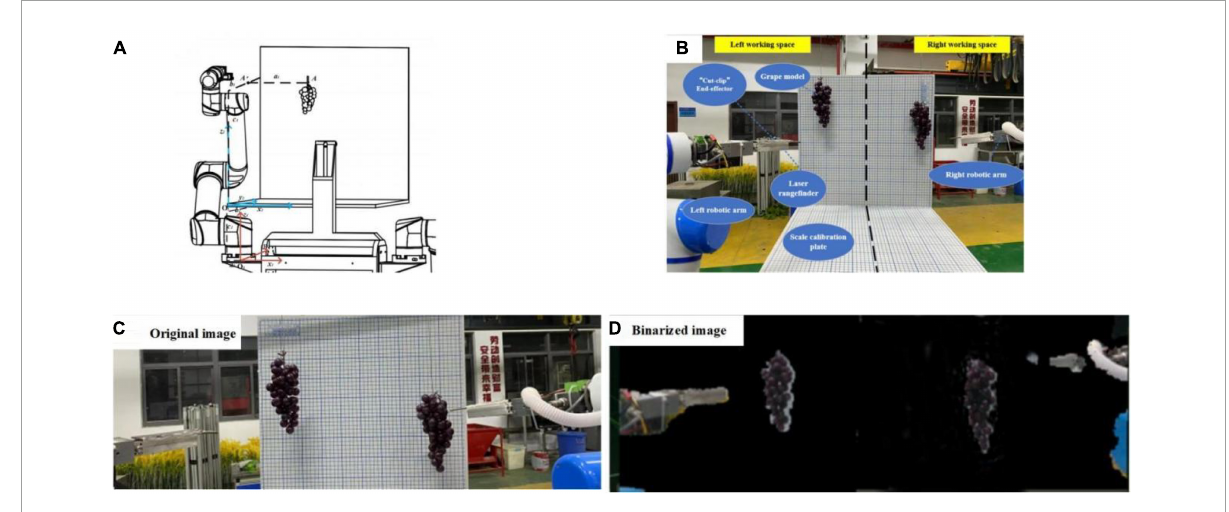
FIGURE16 Dual-arm robot performing grape-harvesting operations.